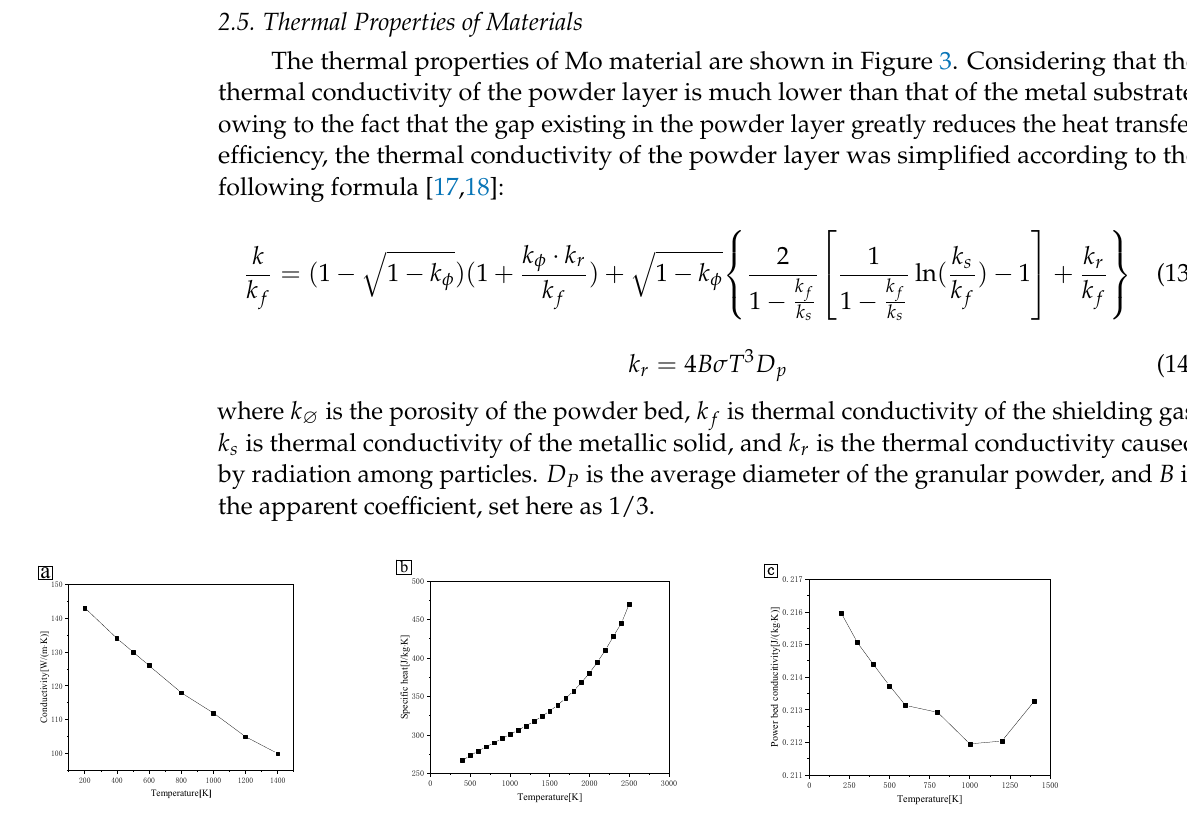
Figure 3. Temperature-dependent parameters of molybdenum alloy. ( a ) metal matrix conductivity; ( b ) specific heat; ( c ) thermal conductivity of powder bed.